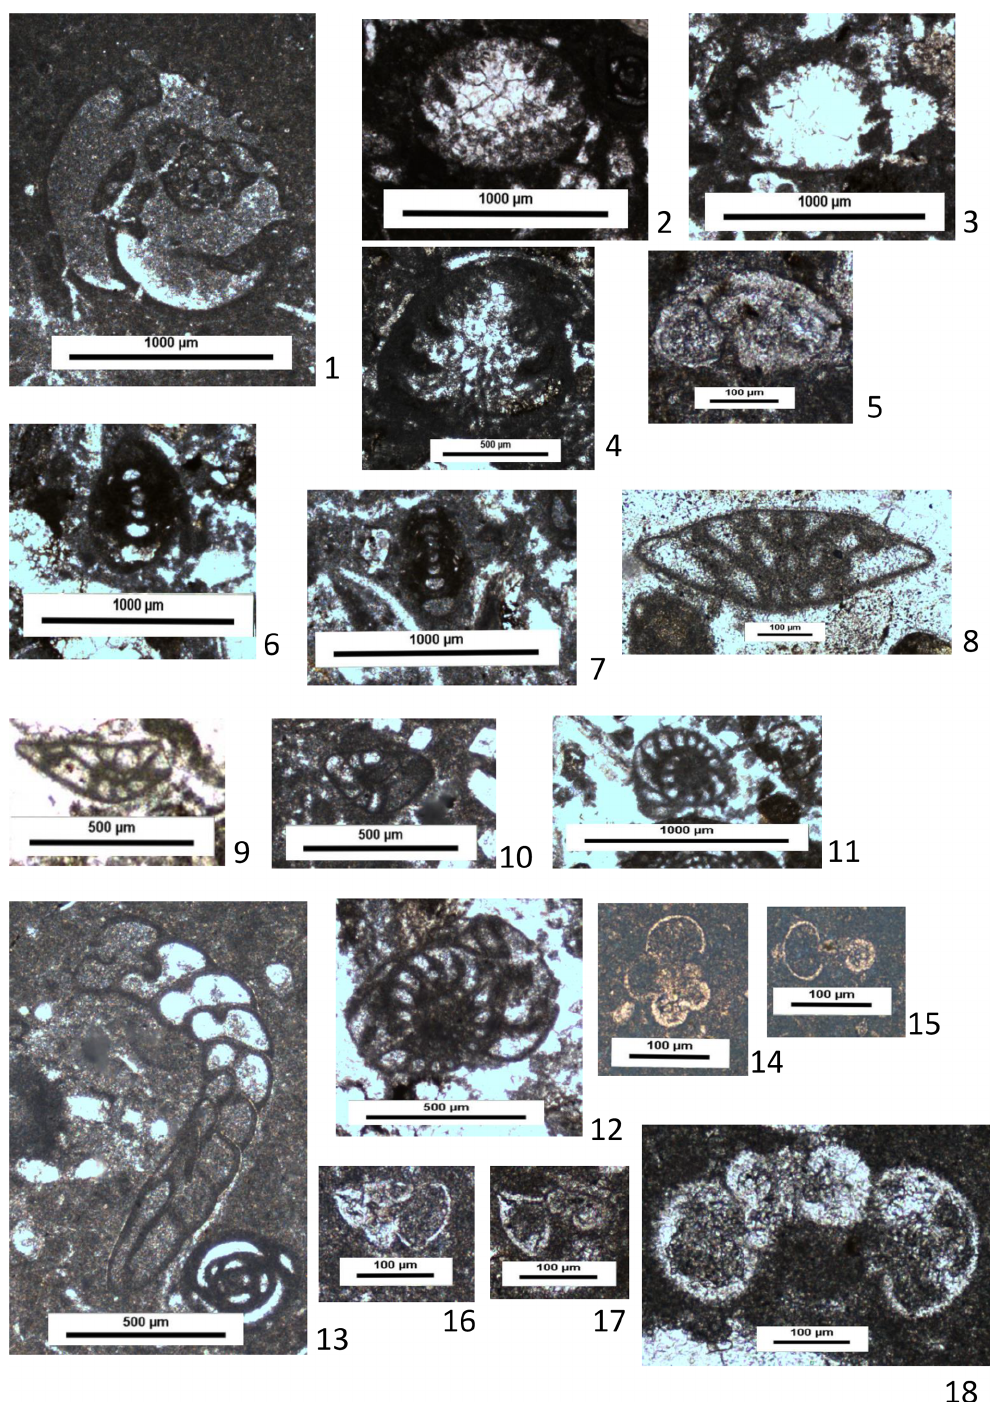
Figure 10. Thin-section photographs of benthonic and planktonic foraminifera from the Derdere Formation at Derik: (1) Chrysalidina gradata d’Orbigny, sample DRK40; (2–4) Coscinoconus intermedius (Henson), samples DRK35 (2–3) and DRK10 (4) ; (5) Rotorbinella mesogeensis (Tronchetti, 1981), sample DRK16; (6–7) Nautiloculina broennimanni Arnaud-Vanneau and Peybernès, samples DRK21 and DRK35; (8–10) Nezzazata simplex Omara, samples DRK23, DRK25, and DRK40; (11–12) Biconcava bentori Hamaoui, samples DRK22 and DRK27; (13) Biplanata peneropliformis Hamaoui and Saint-Marc, sample DRK40; (14–15) indeterminate planktonic foraminifera, sample DRK1; (16–17) Asterohedbergella asterospinosa (Hamaoui), samples DRK28 and DRK36; (18) Whiteinella aprica (Loeblich and Tappan), sample DRK11